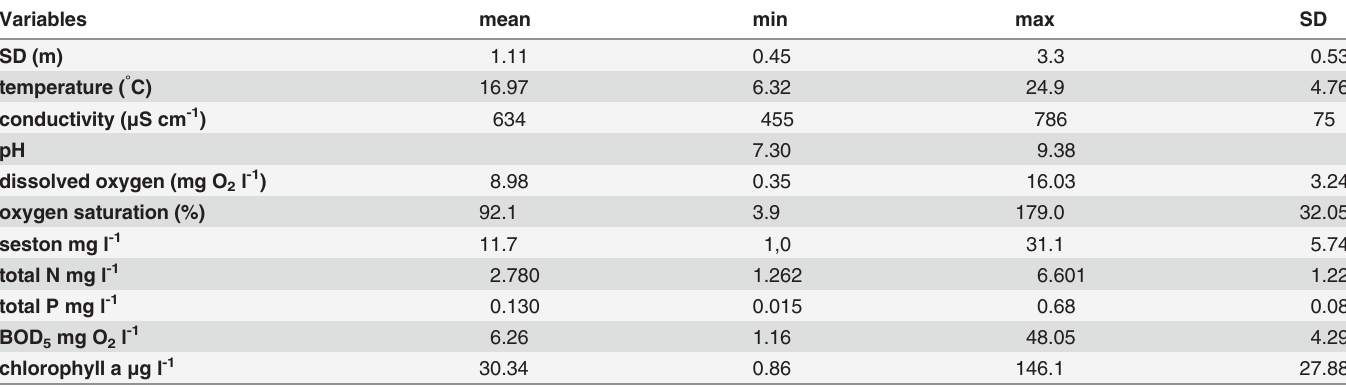
Table 1. Range of physico-chemical data of Malta ń ski